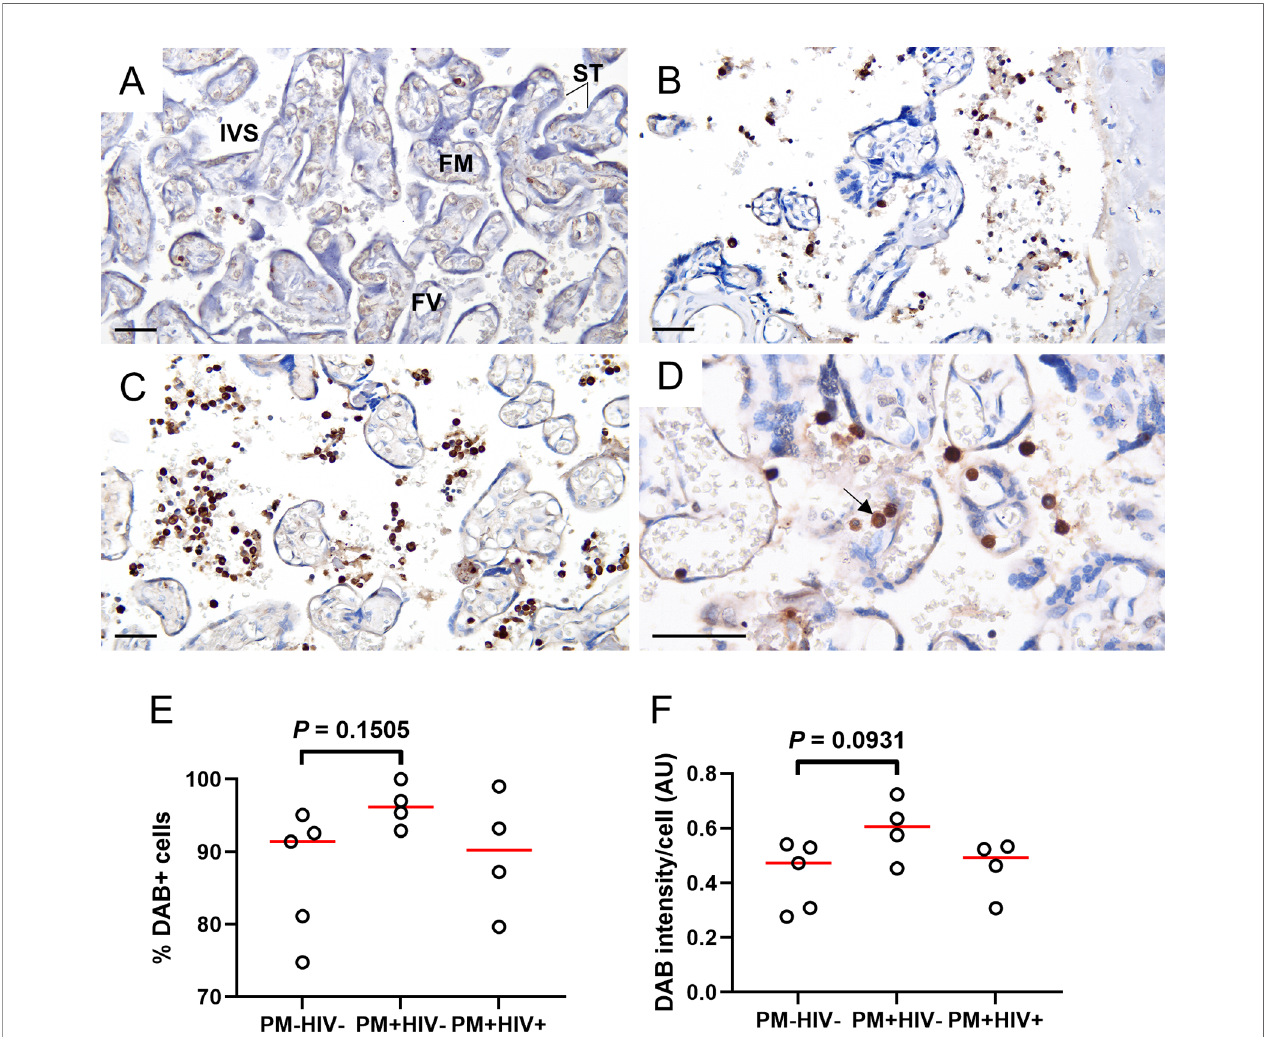
FIGURE 8 | Placental WBCs from PM+HIV- women show more robust MPO expression by immunohistochemistry relative to uninfected and co-infected women. Frequency and intensity of MPO staining is lower in (A) uninfected placenta and (B) PM+HIV+ placenta relative to (C) PM+HIV- placenta. (D) Segmented nucleus clearly delineates MPO staining in a neutrophil (arrow). ST, syncytiotrophoblast; FM, fetal mesenchyme; FV, fetal vessel; IVS, intervillous space. Scale bars represent 50 m m. (E) Percent cells expressing MPO weakly tends to be higher in PM+HIV- relative to uninfected women. (F) MPO staining intensity tends to be higher in PM+ HIV- relative to uninfected women. Statistics by Kruskal-Wallis test with post-hoc group-wise comparisons by Dunn ’ s multiple comparisons test. PM-/HIV-, n = 5; PM+/HIV-, n = 4; PM+/HIV+, n = 4. Groups as de fi ned in Figure 2